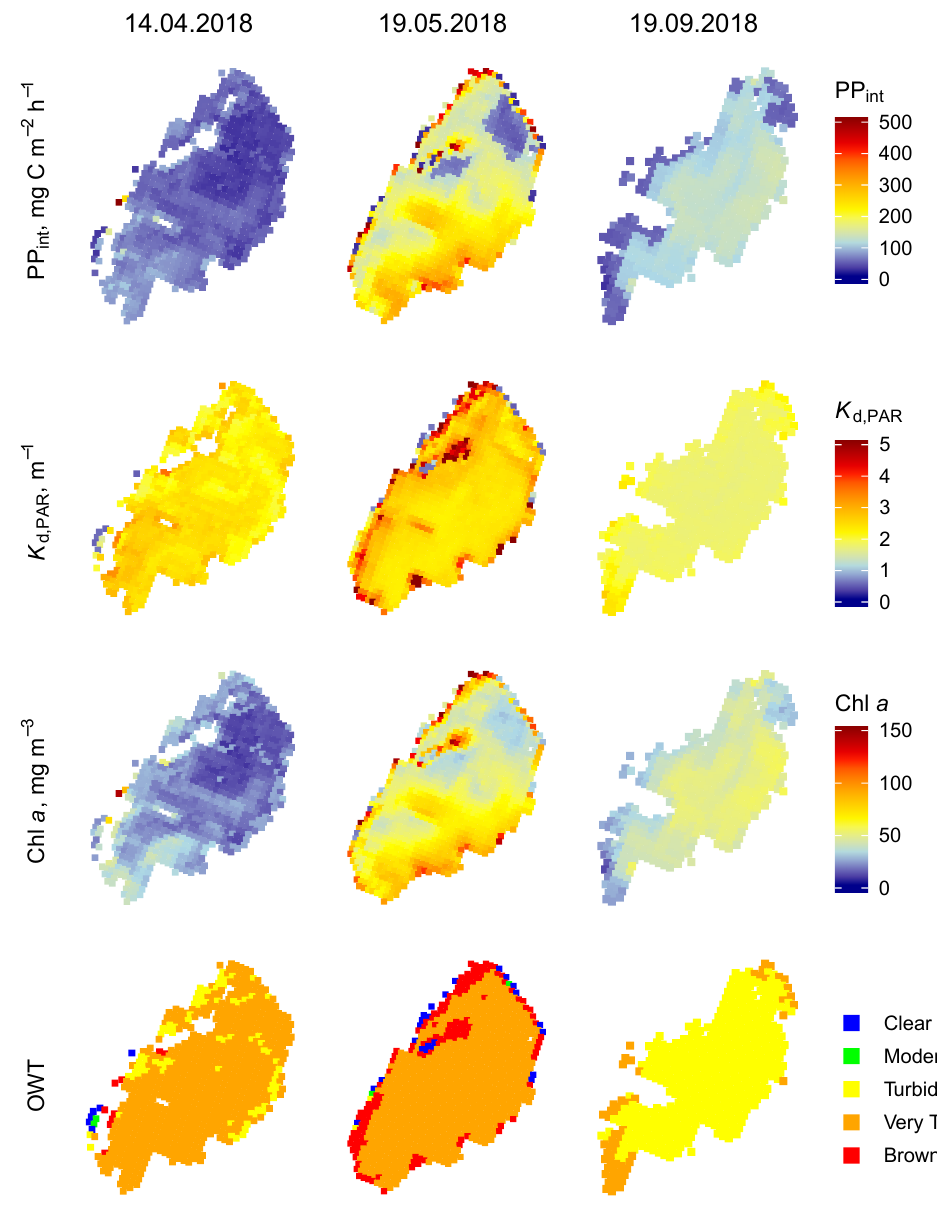
Figure 3. Three examples of the modelled integral primary production (PP int , mg C m − 2 h − 1 ) (first row), attenuation coe ffi cient in the photosynthetically active region ( K d,PAR , m − 1 ) (second row), chlorophyll- a (Chl a , mg m − 3 ) (third row), and optical water type (OWT) (fourth row) of Lake Lubans derived from Ocean and Land Color Instrument (OLCI)